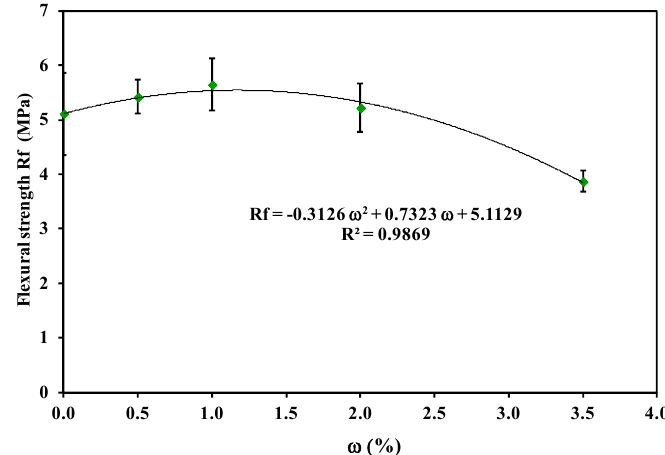
Figure 13. Flexural strength variation as function of AF mass content at day 28. Measurements uncertainty is below 8.5%.